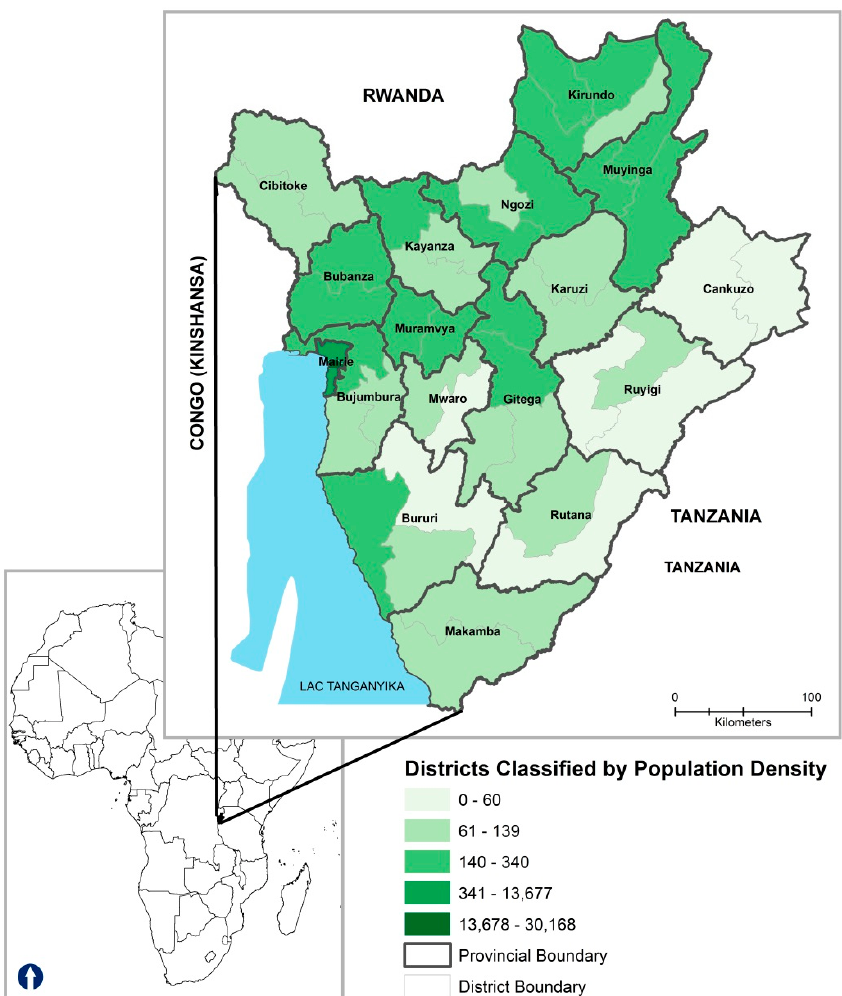
Figure 1. Districts in Study Area, n = 45; Provinces, n = 18.